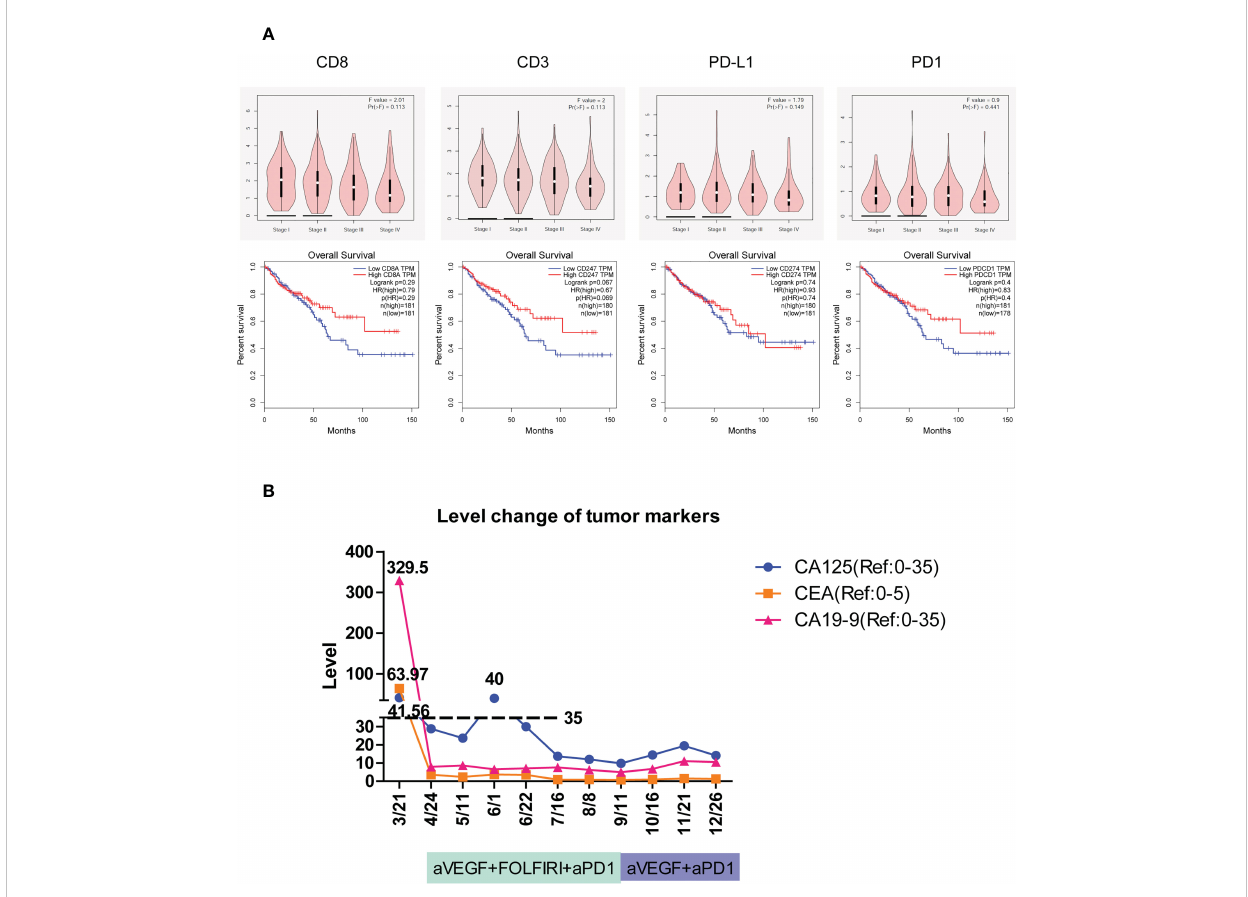
FIGURE 5 The tumor immune signatures may be potentially applied to predict the development of colorectal cancer, patient survival, and the responsiveness of immune checkpoint inhibition. (A) According to GEPIA of TCGA data, the expression of immune response genes including CD8, CD3, PD-L1, and PD-1 is gradually reduced with the development of colorectal cancer from stage I through stage IV. The overall survival of patients with colorectal cancer is elevated in high-expression groups of CD8, CD3, PD-L1, and PD-1 compared to that in low-expression groups. HR, hazard ratio. (B) The level change of three cancer markers during combination therapy of anti-PD-1 on patient #2C of immune excluded indicates the complete